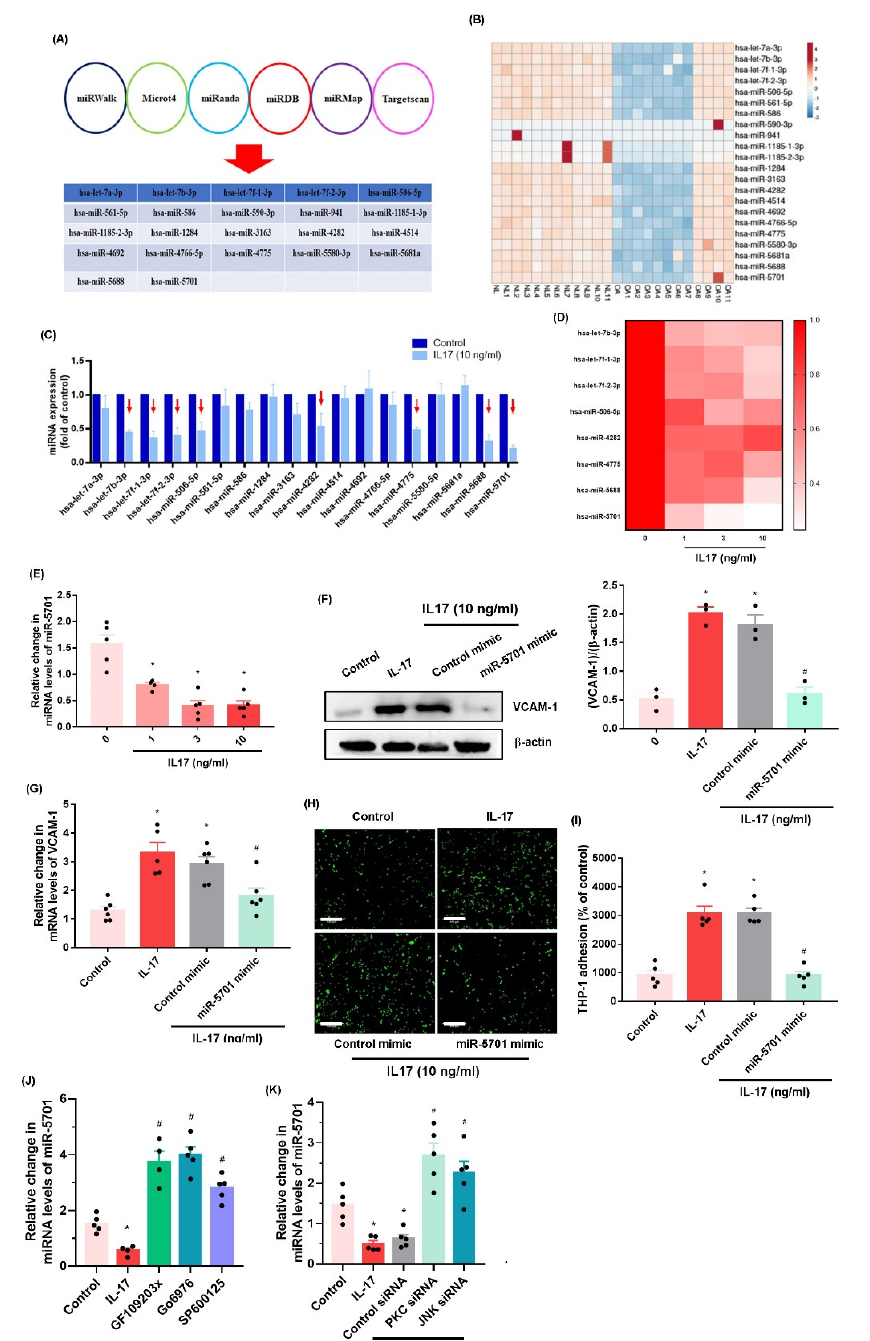
Figure 5. IL-17 enhances VCAM-1 production by inhibiting miR-5701 expression. ( A ) Six software databases were examined to predict which miRNAs interfere with VCAM-1 transcription. ( B ) Levels of miRNAs were investigated in OA and normal, healthy synovial tissue collected from the GEO database. ( C – E ) OASFs were treated with IL-17 (10 ng/mL). miRNA expression was examined by qPCR. ( F , G ) OASFs were transfected with miR-5701 mimic and then treated with IL-17 (10 ng/mL). VCAM-1 expression was examined by Western blot and qPCR. ( H , I ) Adherent THP-1 cells were photographed and quantified under fluorescence microscopy. ( J , K ) OASFs were stimulated with PKC and JNK inhibitors for 30 min or the respective siRNAs for 24 h and then incubated with IL-17 (10 ng/mL). miR-5701 expression was examined by qPCR. Size bar = 320 µ m. * p < 0.05 compared with the control group; # p < 0.05 compared with the IL-17-stimulated